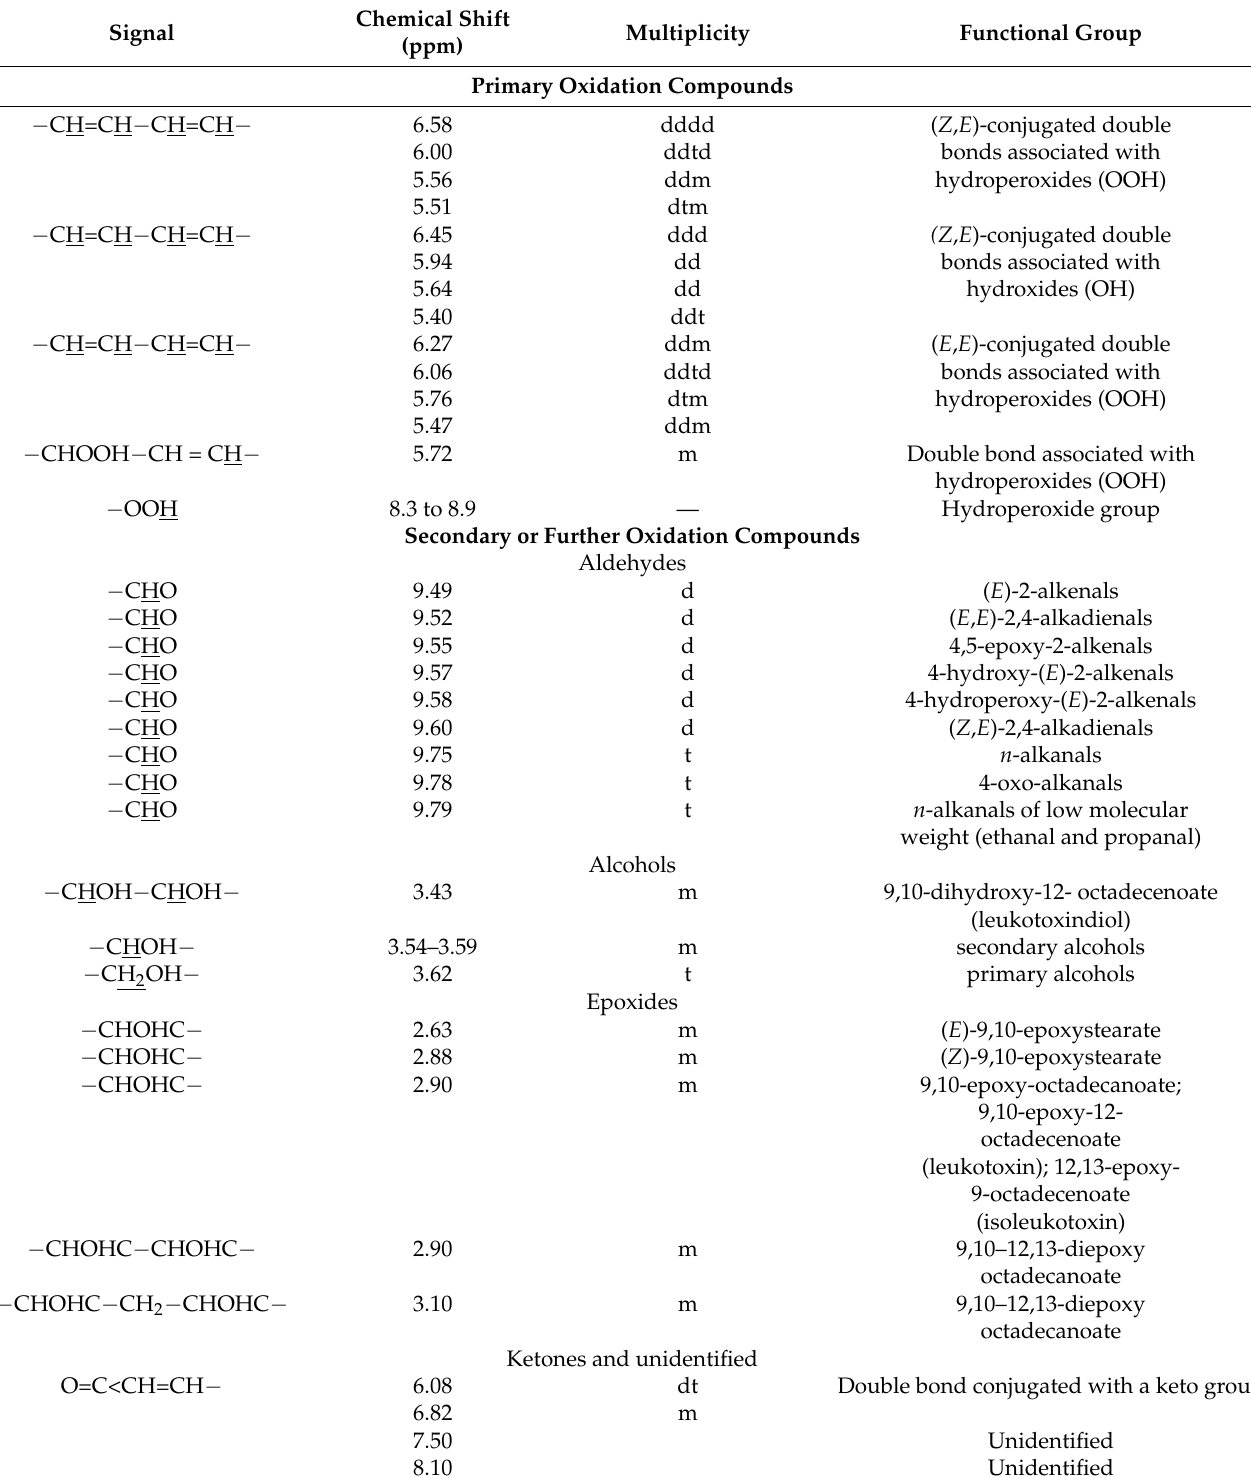
Table 3. 1 H-NMR chemical shifts and spin multiplicities of oxidation products of edible lipids. Adopted with permission from [102]. Copyright 2014, Institute of Food